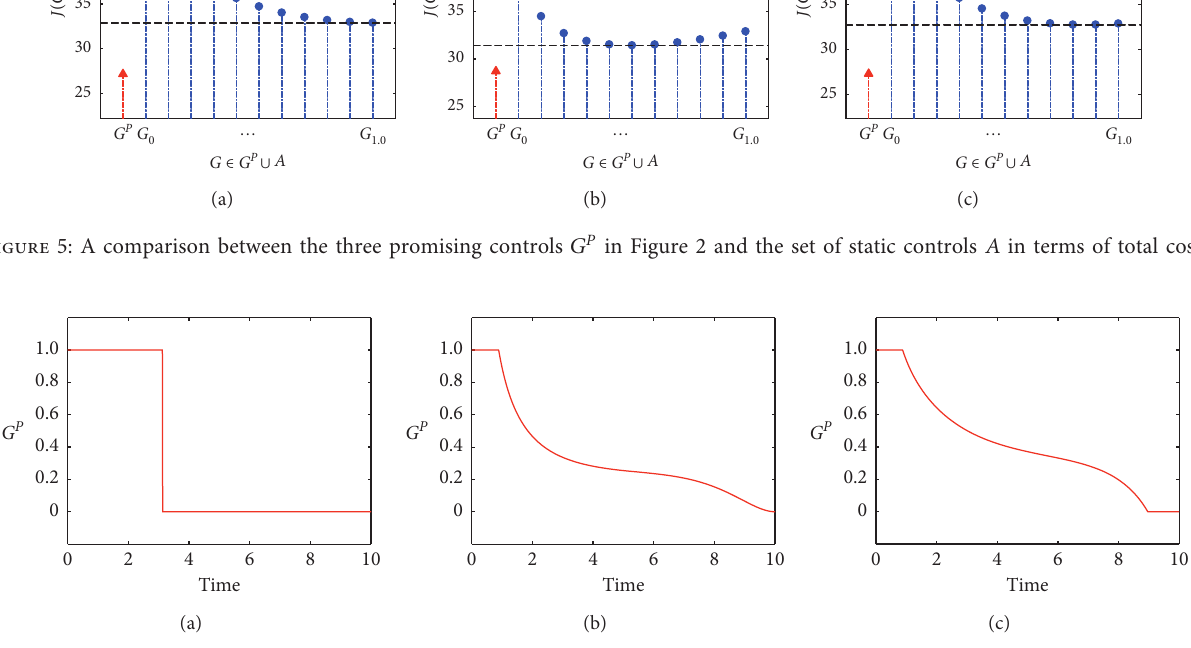
( x ) , θ ( x )) functions: (a) θ 1 2